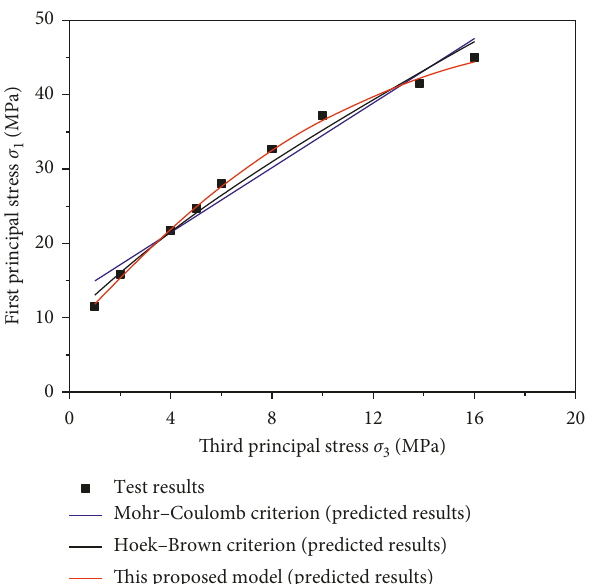
Figure 4: Comparisons between predicted results and experi- mental data.